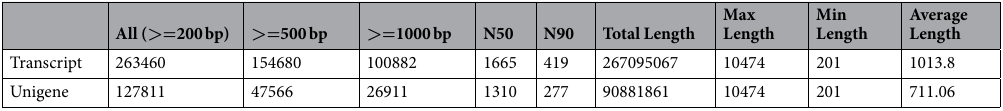
Table 1. The result of de novo